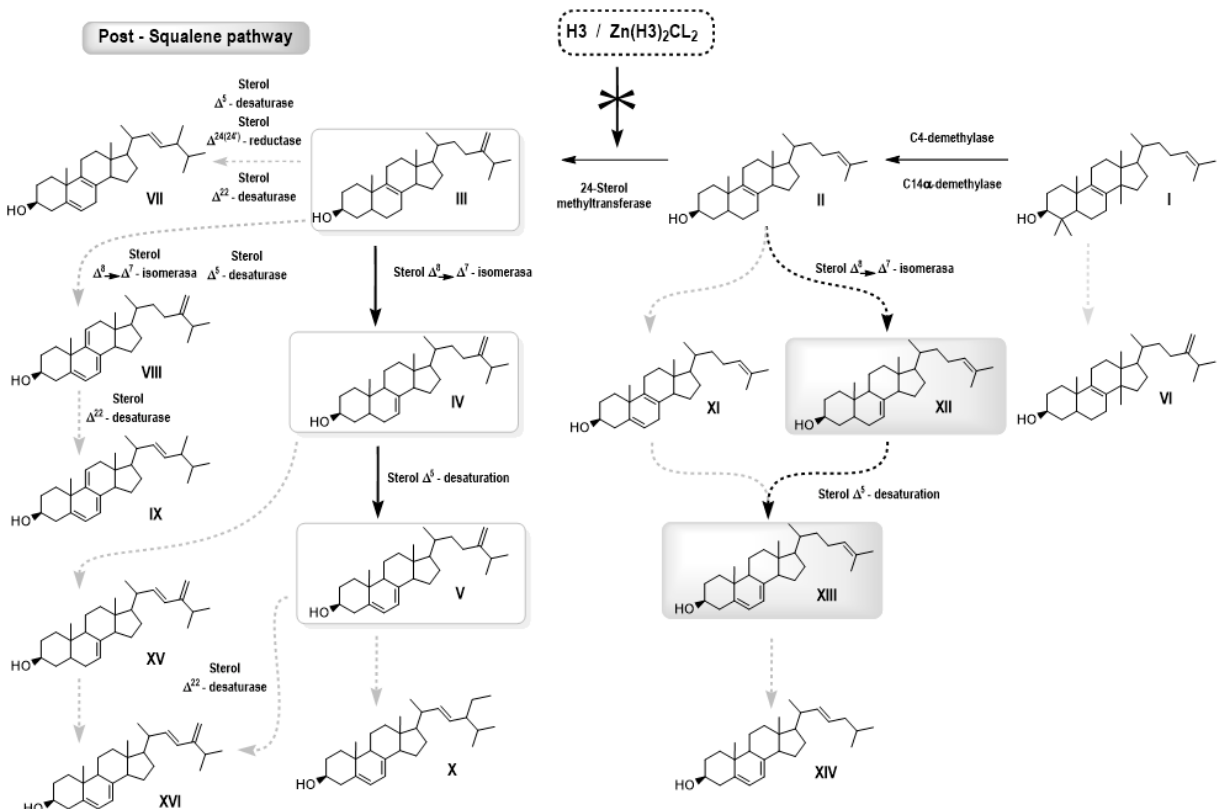
Figure 9. Diagram of the sterol biosynthesis pathway in L. amazonensis obtained from the sterols identified in the current study. (I) 4,4 (cid:48) ,14-Trimethyl-cholesta-8,24-dien-3 β -ol (lanosterol); (II) cholesta-8,24-dien-3 β -ol (zymosterol); (III) ergosta-8,24(24 (cid:48) )-dien-3 β -ol (fecosterol); (IV) ergosta-7,24(24 (cid:48) )-dien-3 β -ol (episterol); (V) ergosta-5,7,24(24 (cid:48) )-dien-3 β -ol (5-dehydro-episterol); (VI) 14-methyl-ergosta-8,24(24 (cid:48) )-dien-3 β -ol; (VII) ergosta-5,8,22-trien-3 β -ol; (VIII) ergosta-5,7,9(11)-24(24 (cid:48) )-tetraen-3 β -ol; (IX) ergosta-5,7,9(11)-22-tetraen-3 β -ol; (X) stigmasta-5,7,22-trien-3 β -ol; (XI) cholesta-5,8,24-trien-3 β -ol; (XII) cholesta-7,24-dien-3 β -ol; (XIII) cholesta-5,7,24-trien-3 β -ol; (XIV) cholesta-5,7,22-trien-3 β -ol; (XV) ergosta-7,22-24(24 (cid:48) )-trien-3 β -ol; (XVI) ergosta-5,7,22-24(24 (cid:48) )-tetraen-3 β -ol. Thick lines and arrows indicate the main reaction pathways in control cells. The gray dashed arrows show intermediate sterols of lower quantities. The dotted line rectangle and arrow marked with an ‘X’ indicate the interaction of H3 and ZnCl 2 ( H3 ) 2 with SMT and the ensuing interference in the C-24 methylation process, resulting in a blockage of 5-dehydroepisterol synthesis and accumulation of cholesta-type sterols. The black dashed arrows show intermediate sterols by inhibition of the SMT. Incubation of promastigotes with increasing concentrations of H3 (3 µM–7 µM) or